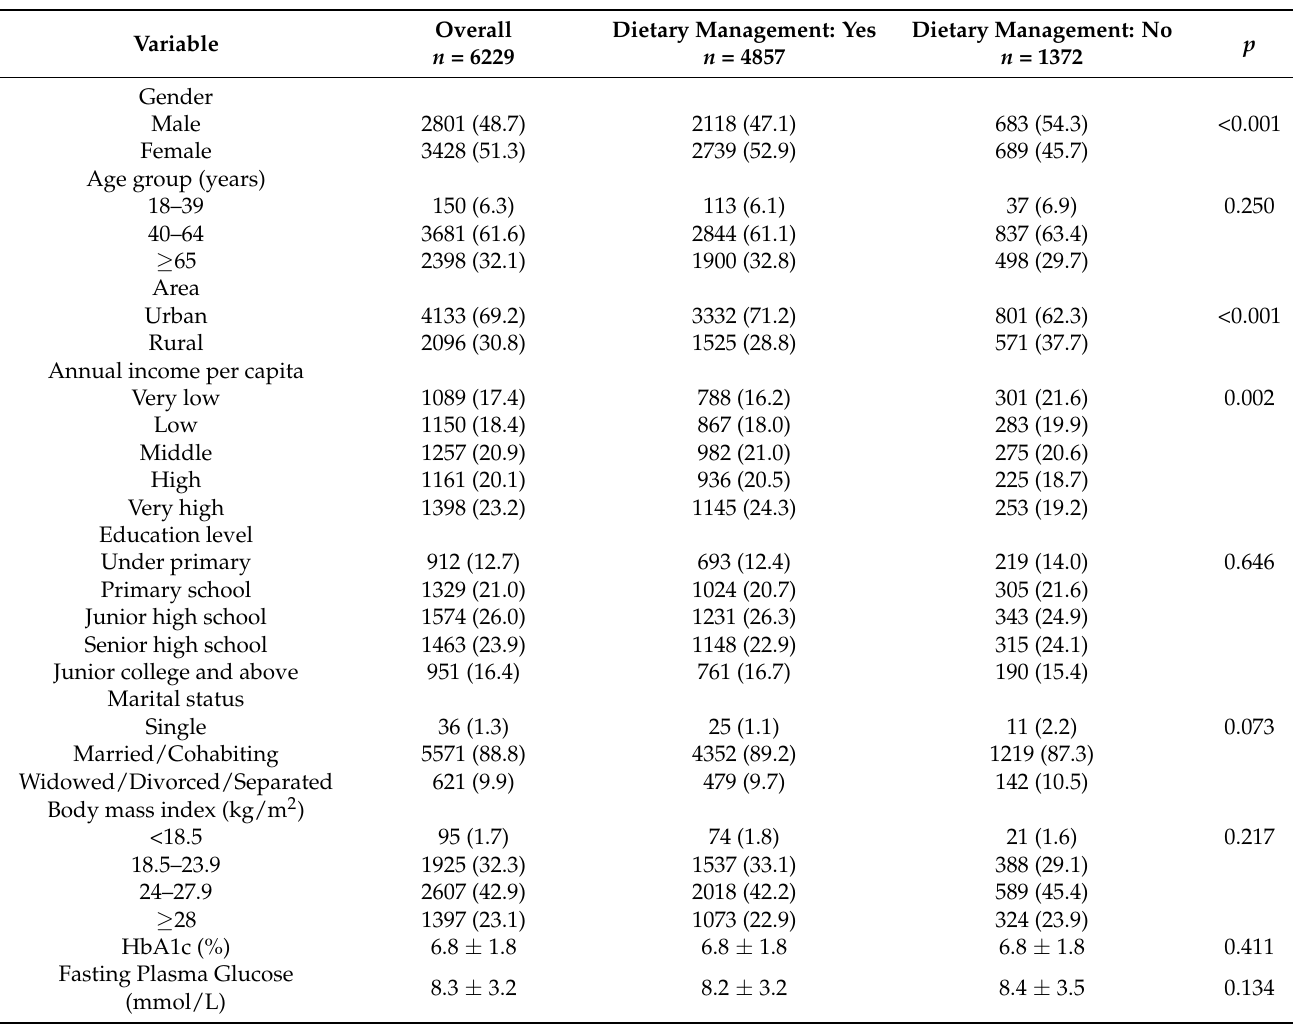
Table 1. Characteristics of adults with diabetes in the three rounds of China National Nutrition